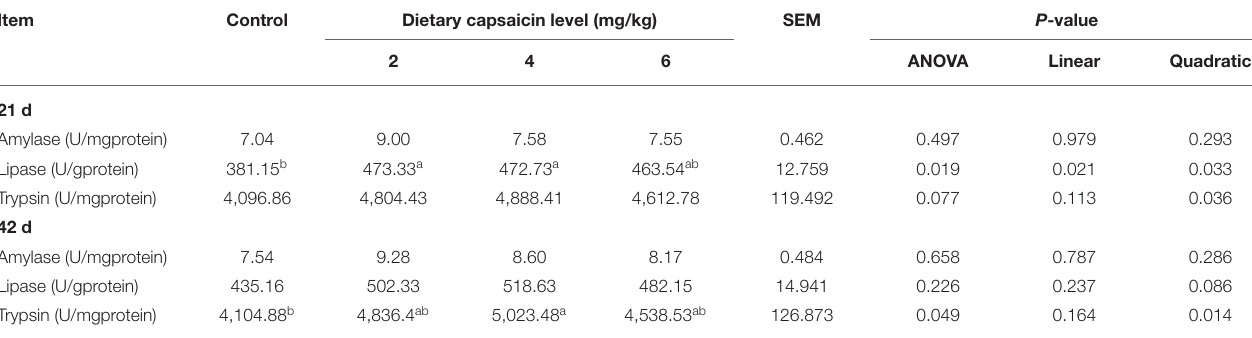
TABLE 5 | Effects of different levels of capsaicin on the digestive enzyme activities of jejunal contents of